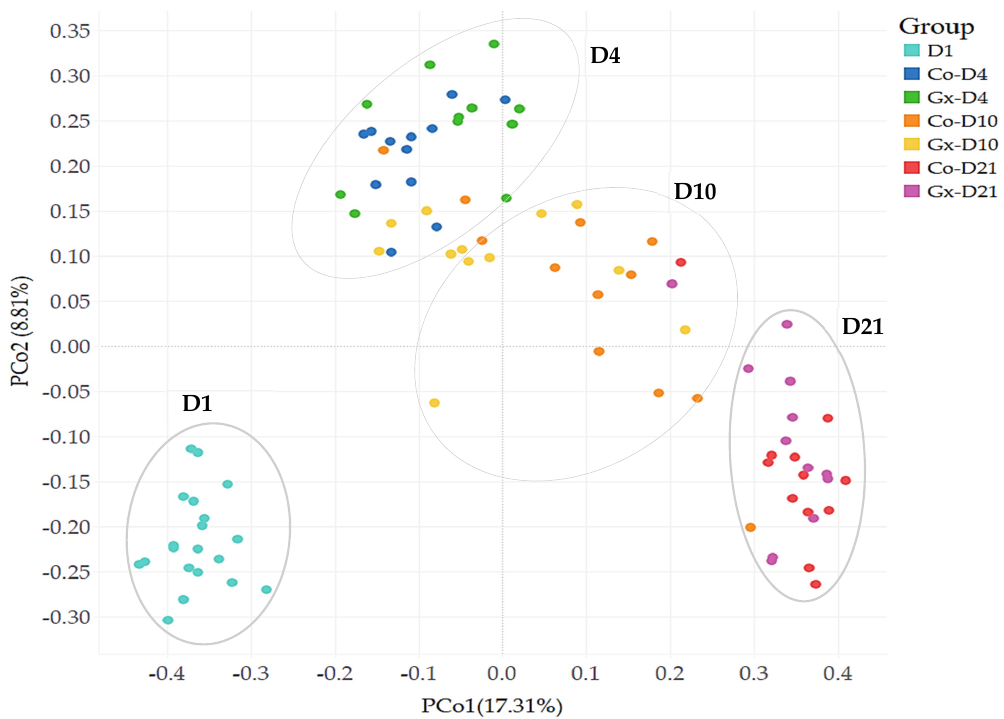
Figure 3. Comparison of fecal bacterial communities between supplemented (Gx) and non-supplemented (Co) samples at different time points (D1, D4, D10, D21). Principal Coordinate Analysis (PCoA) was performed using a Bray-Curtis distance matrix. The x and y axes correspond to Principal Components 1 (PCo1) and 2 (PCo2), which together explain 26.12% of the variance. PERMANOVA and adonis tests indicated differences between groups ( p = 0.001 for all group comparisons). Table 3. Mean relative abundance of the main bacterial OTUs in fecal bacterial communities of weaned pigs supplemented (Gx) or not supplemented (Co) with phytoextracts. Abundance is presented as a percentage (%) of the total number of analyzed reads per sample.